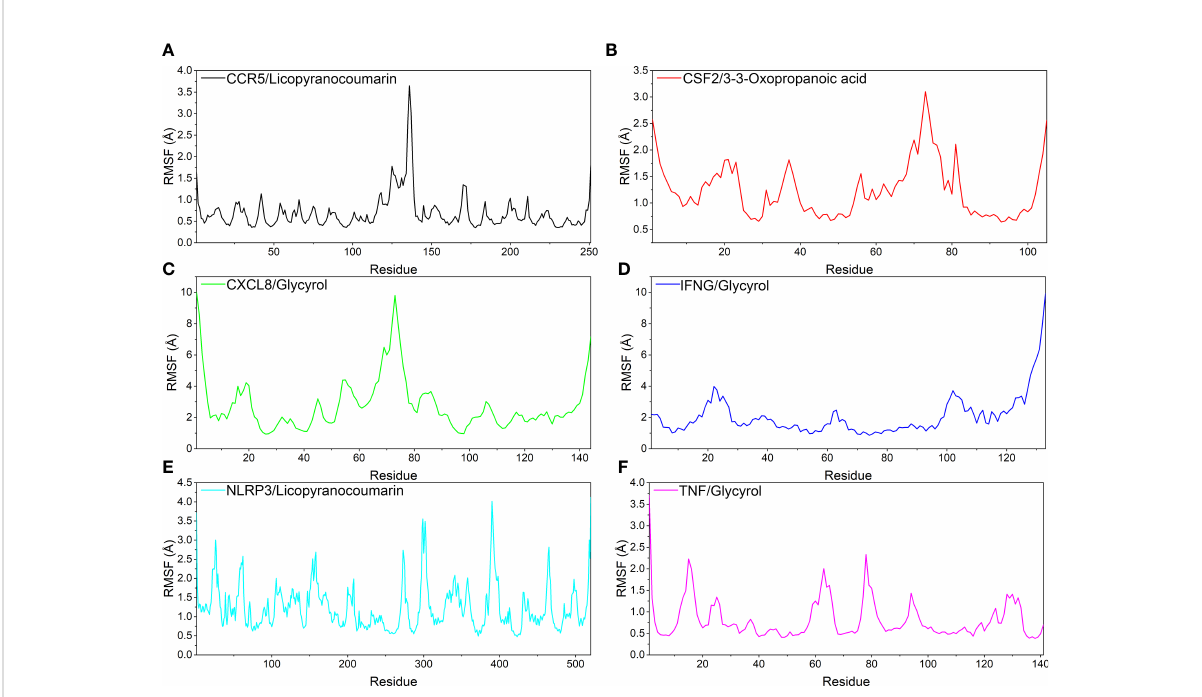
FIGURE 7 The result of root mean square fl uctuations (RMSF). (A) CCR5/Licopyranocoumarin, (B) CSF2/3-3-Oxopropanoic acid, (C)